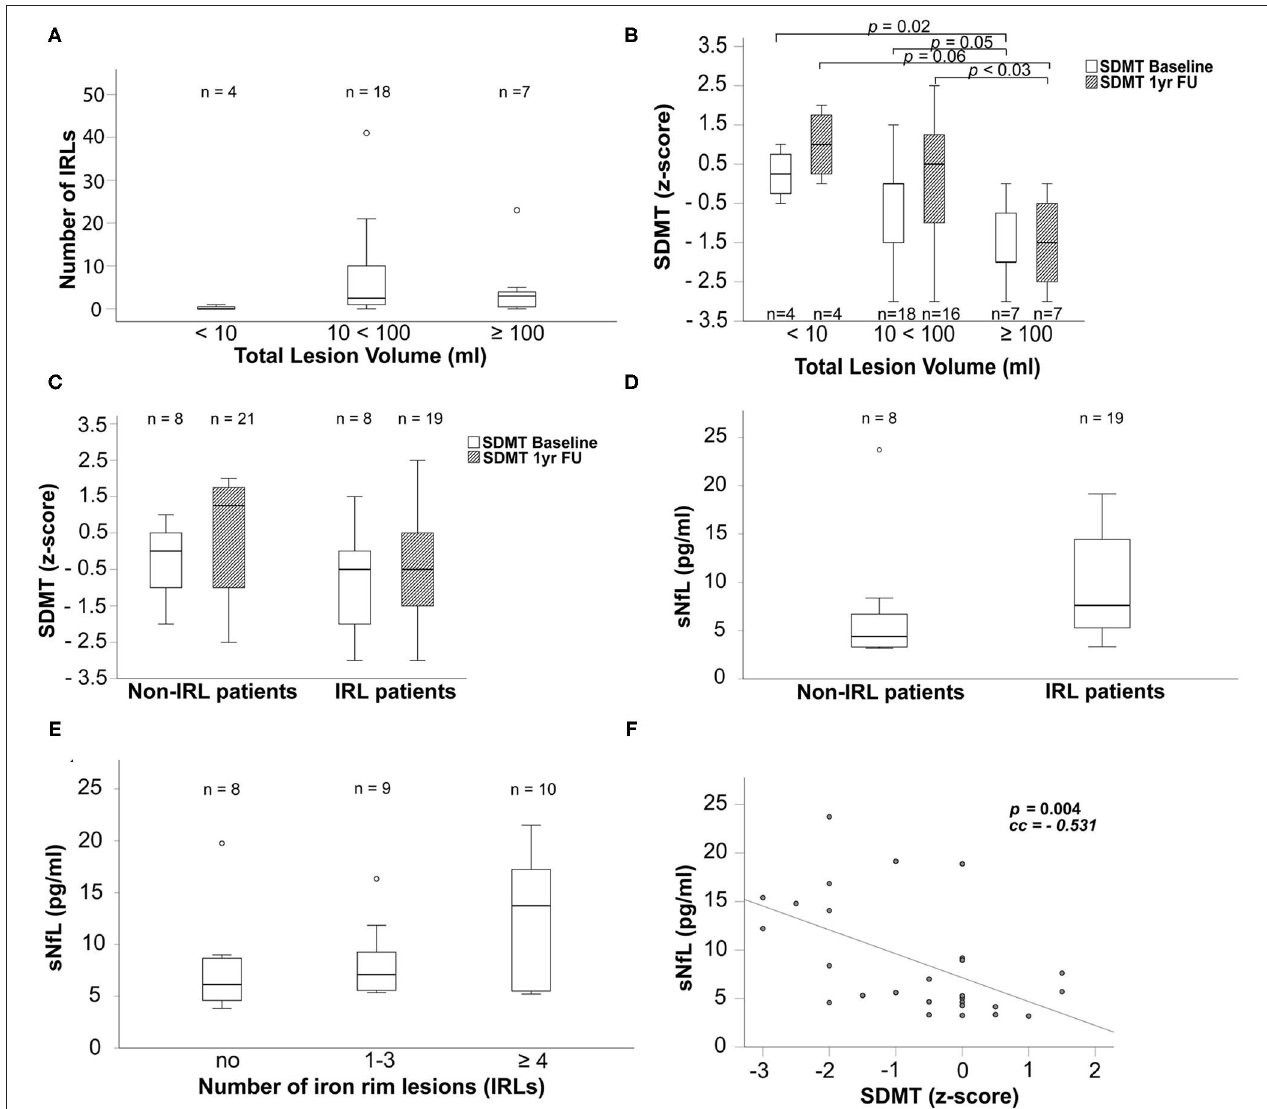
FIGURE 3 | Boxplots display in (A) the number of iron rims in patients grouped by their MP2Rage total lesion volume in ml, in (B) SDMT z -scores grouped according to the MP2Rage total lesion volume in ml at baseline (white bars) and 1yr FU (cross-hatched bars), in (C) SDMT z -scores grouped according to non-IRL and IRL patients at baseline (white bars) and 1yr FU (cross-hatched bars), in (D) sNfL concentrations in pg/ml in non-IRL and IRL patients and in (E) sNfL concentrations in pg/ml grouped according to count of IRLs. (F) The scatter plot reflects the relationship between sNfL concentrations and the SDMT. Number of evaluated patients is given within the graphs. The p- values of boxplots indicate results from non-parametric Kruskal–Wallis tests and post-hoc Mann–Whitney U- tests. The p- value of the scatterplot indicates the Spearman’s rank correlation coefficient used to evaluate the bivariate correlation. Only significant p- values are given. IRLs, iron rim lesions; FU: follow-up; SDMT, symbol digit modalities test; sNfL, serum neurofilament light chain; yr, year.